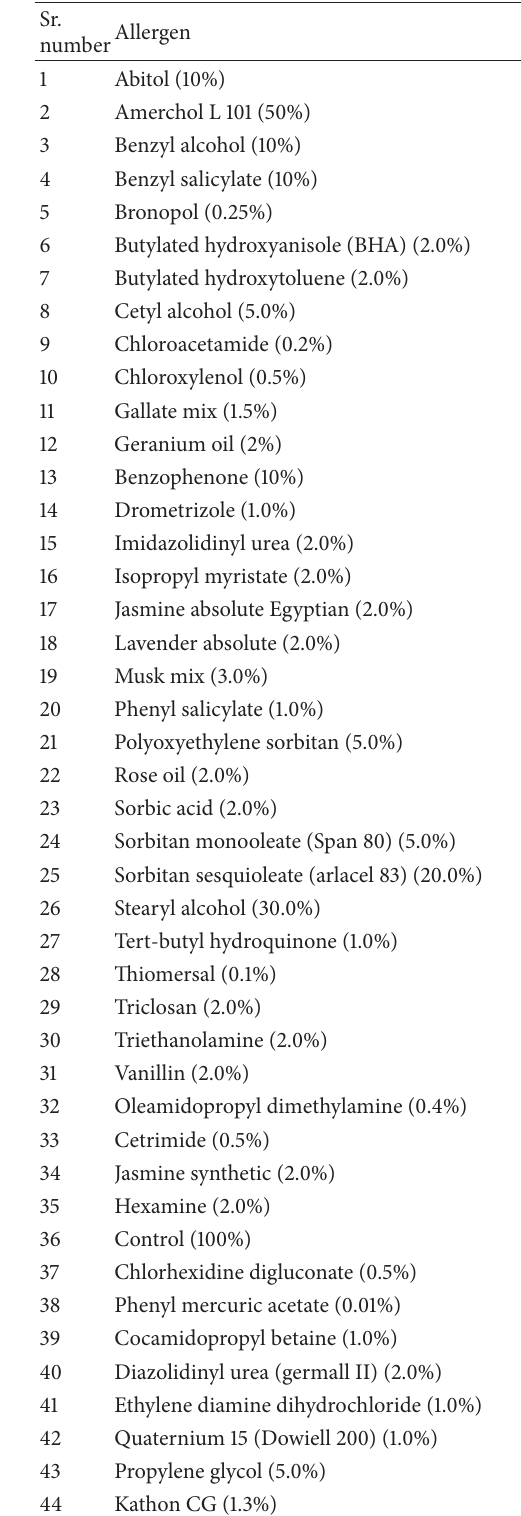
Table 1: Indian Cosmetic and Fragrance Series ∗